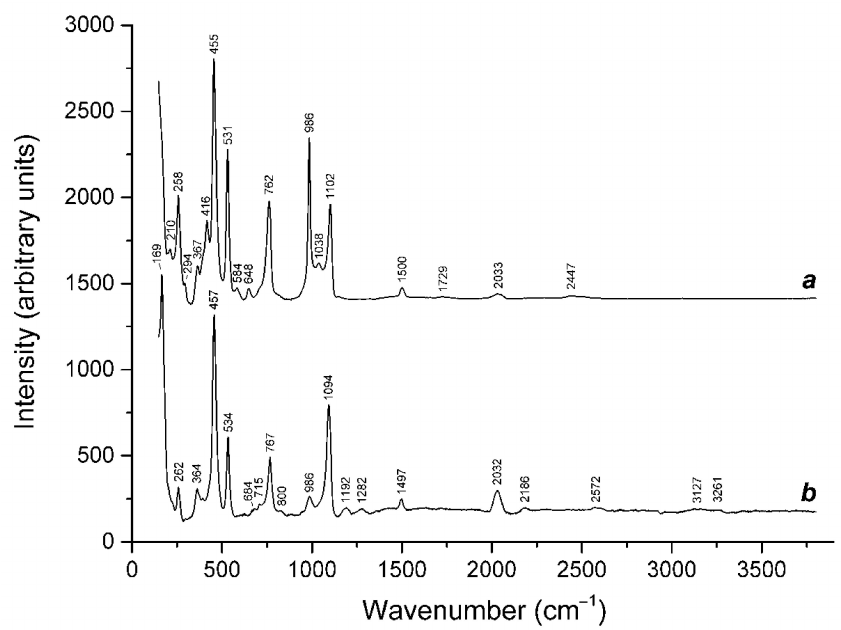
Figure 25. Raman spectra of ( a ) SO 4 2 − -rich meionite (Sample 15) and ( b ) SO 4 2 − -poor meionite (Sample